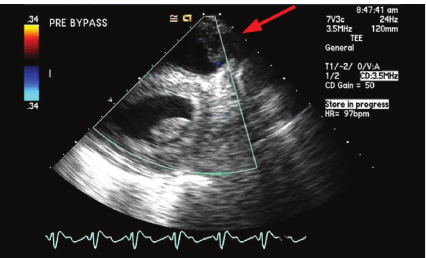
Figure2:Transesophagealechocardiography:midesophagealaortic valve long axis view at 102 ∘ . Evidence of obstruction in the right ventricular outflow tract (Arrow) and pulmonary conduit.